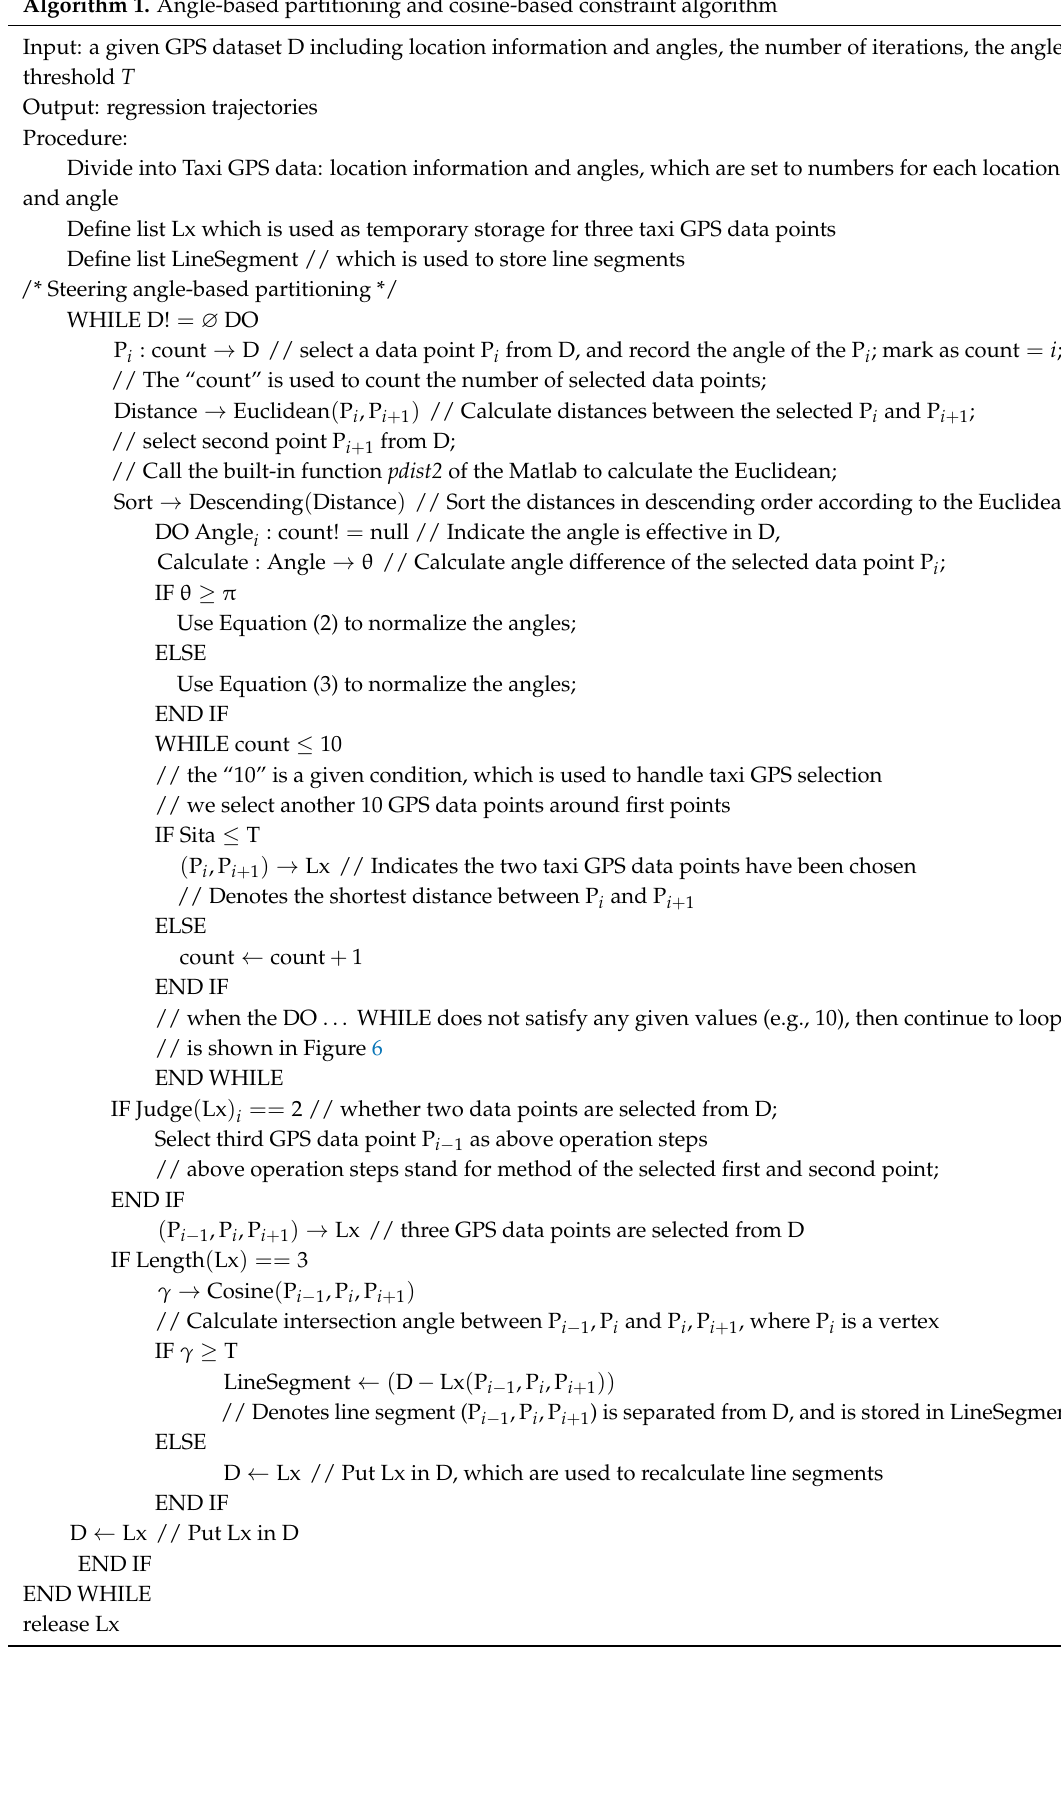
Algorithm 1. Angle-based partitioning and cosine-based constraint